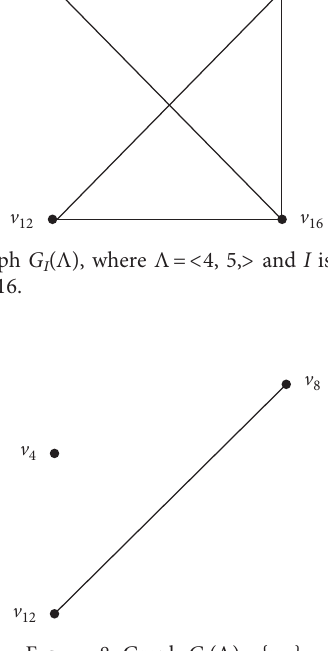
Figure 8: Graph G